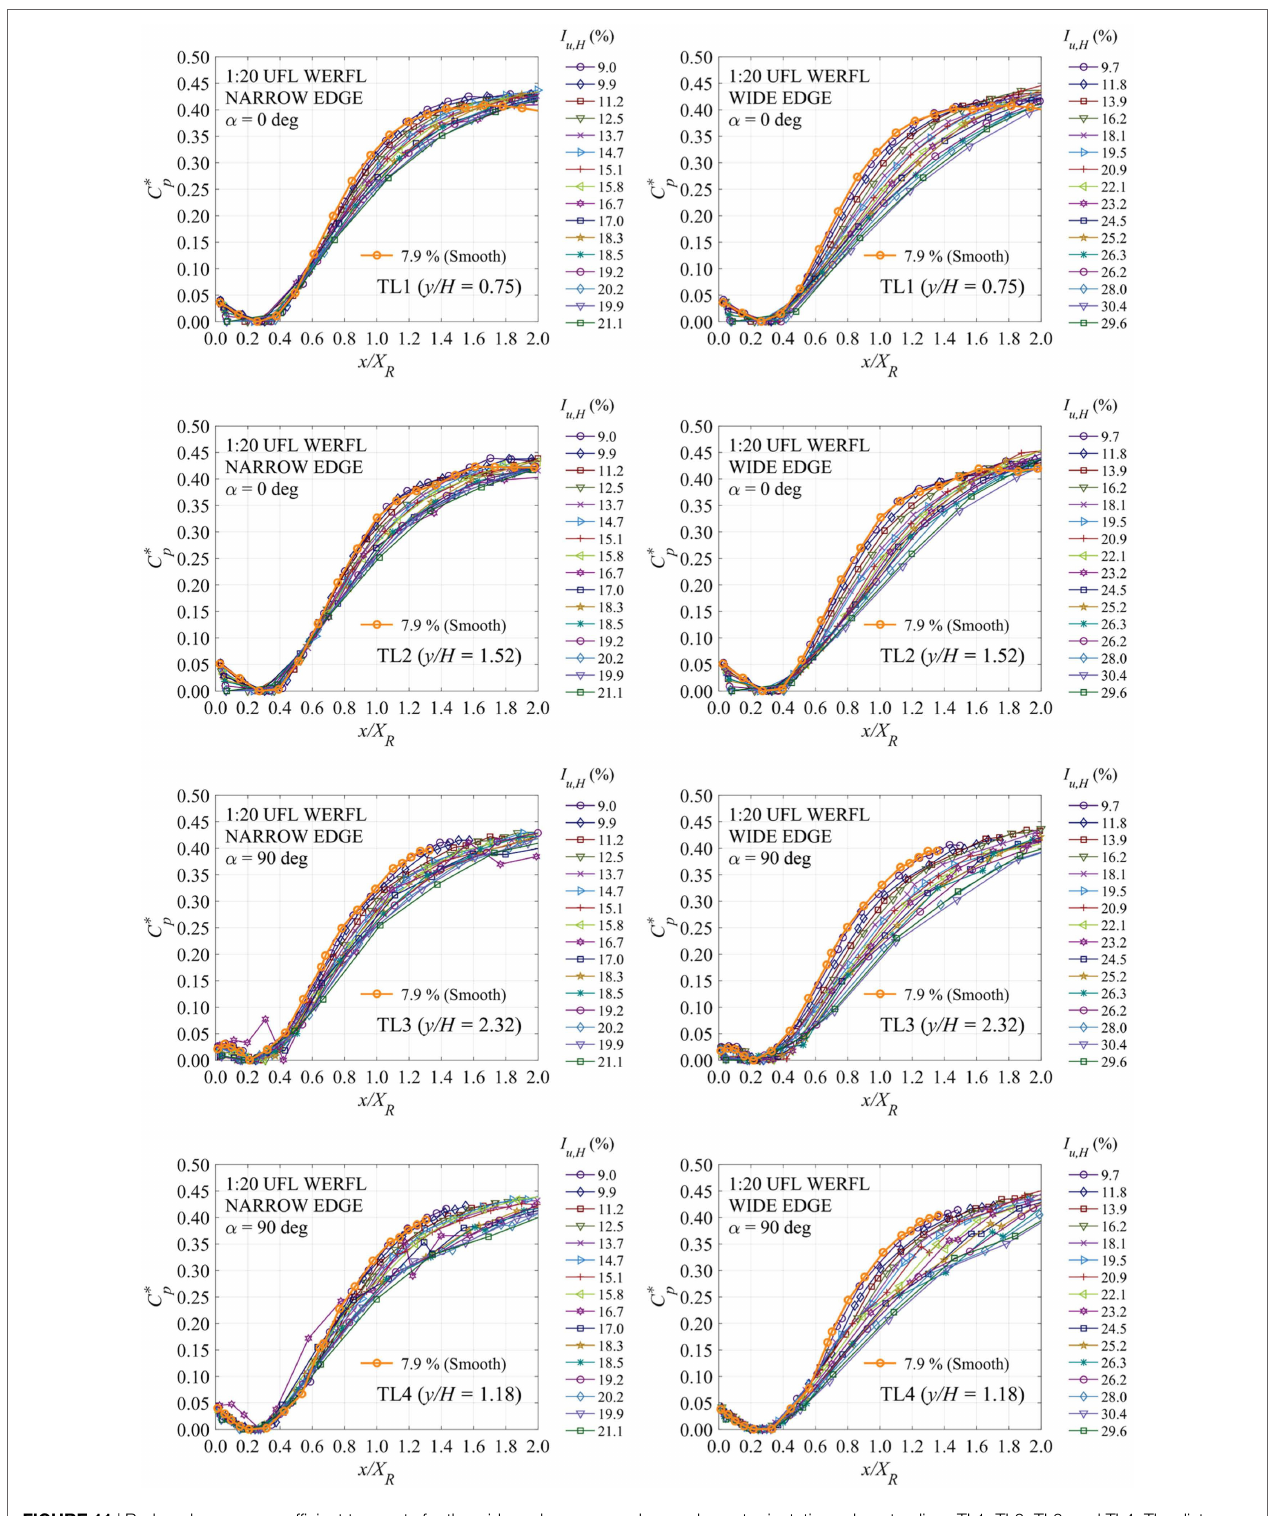
FIGURE 11 | Reduced pressure coefficient transects for the wide and narrow roughness element orientations along tap lines TL1, TL2, TL3, and TL4. The distance from the leading edge is normalized by the mean reattachment length.